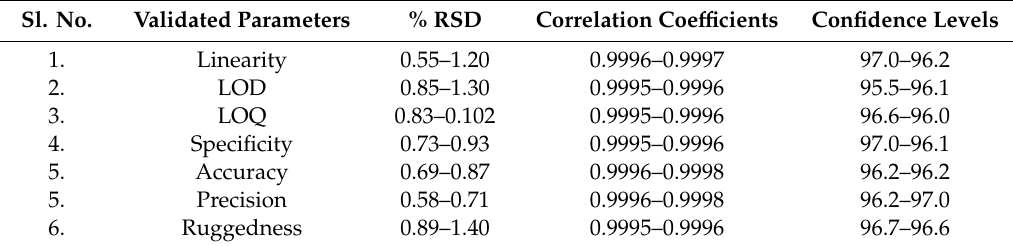
Table 1. Validation parameters of capillary electrophoresis.